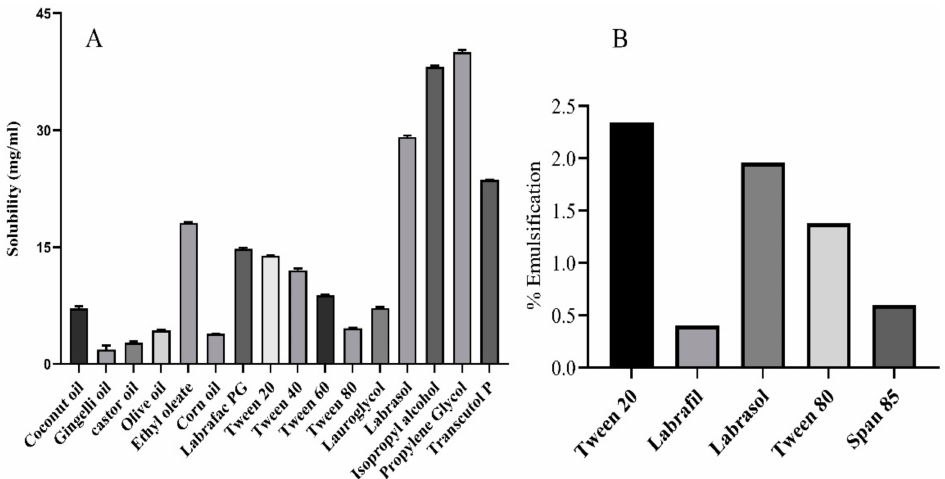
Figure 1. ( A ) Quercetin solubility in various nanoemulsion components; ( B ) ethyl oleate emulsifica- tion by selected